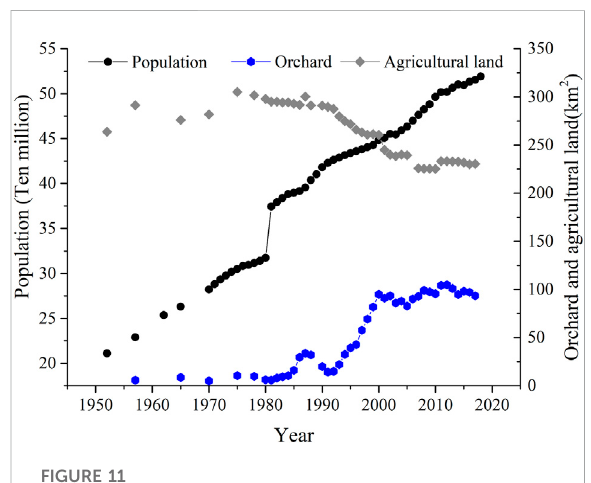
FIGURE 11 Agricultural land, orchard and population changing trend in the Wanquan river